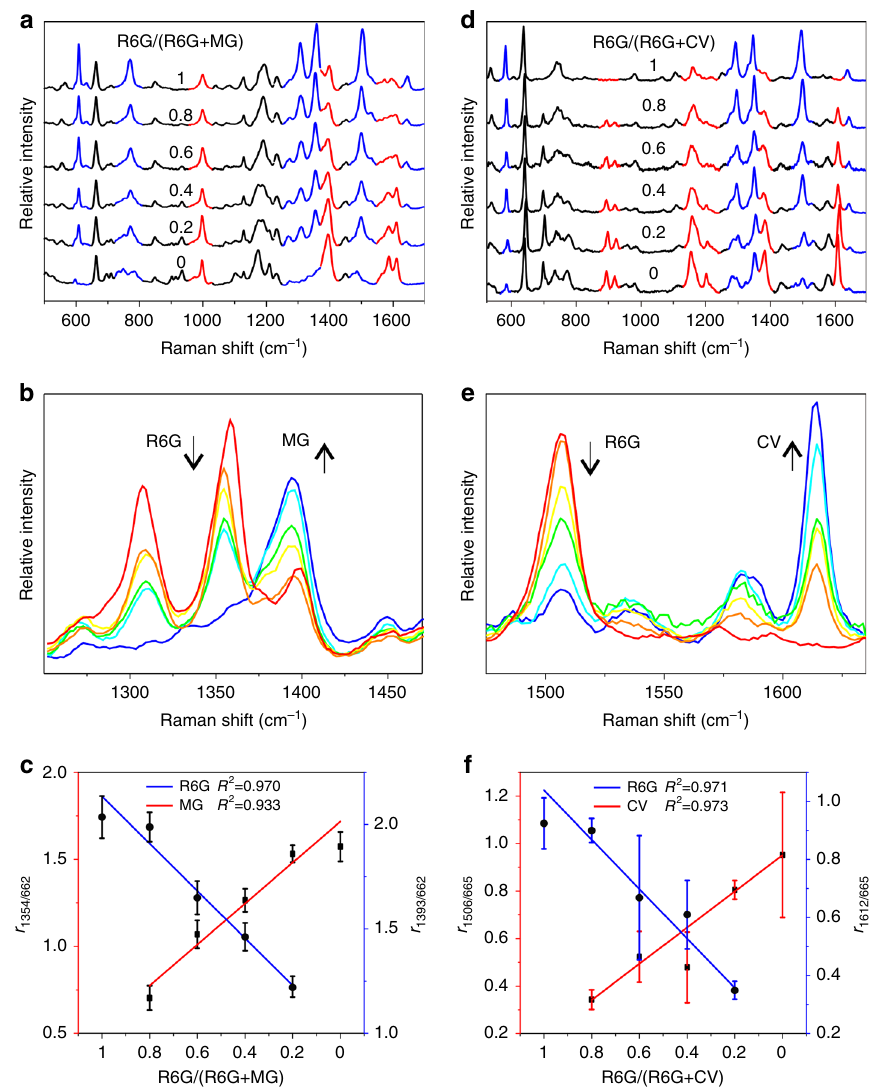
Fig. 8 A quantitative liquid-state SERS platform. a Multiphase analysis of MG dissolved in the W phase and R6G dissolved in the O phase. b Detailed spectral variations of the 1354 cm − 1 band assigned to R6G and the 1393 cm − 1 band assigned to MG in multiphase analysis. c The linear relationships between the R6G/MG molar ratios and the r values of MG (red) and R6G (blue), respectively. d Multiplex analysis of R6G and CV simultaneously dissolved in the O phase. e Detailed spectral variations of the 1506 cm − 1 band assigned to RG and the 1612 cm − 1 band assigned to CV in multiplex analysis. f The linear relationships between the R6G/CV molar ratios and the r values of CV (red) and R6G (blue), respectively. Total number of molecules in each experiment was 0.1 nmol, and the molar ratio was labeled on each spectrum. The error bars represent the statistical RSD and were calculated from triplicate SERS